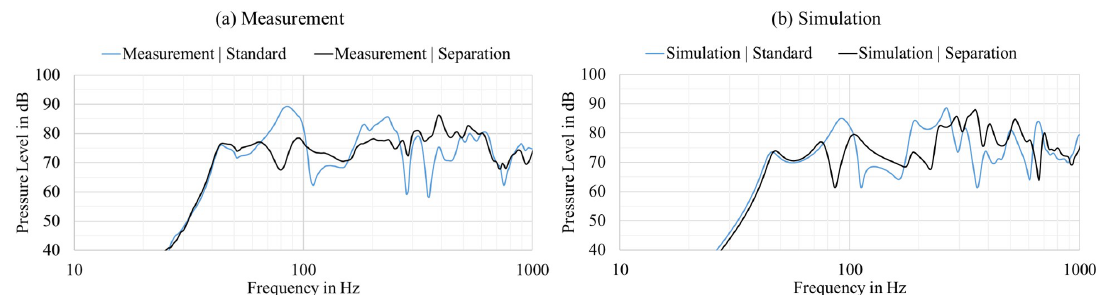
Figure 10. Validation of the measured and simulated pressure response of the standard panel and the panel with separation plate construction at 1 m distance and with 2.83 Vrms